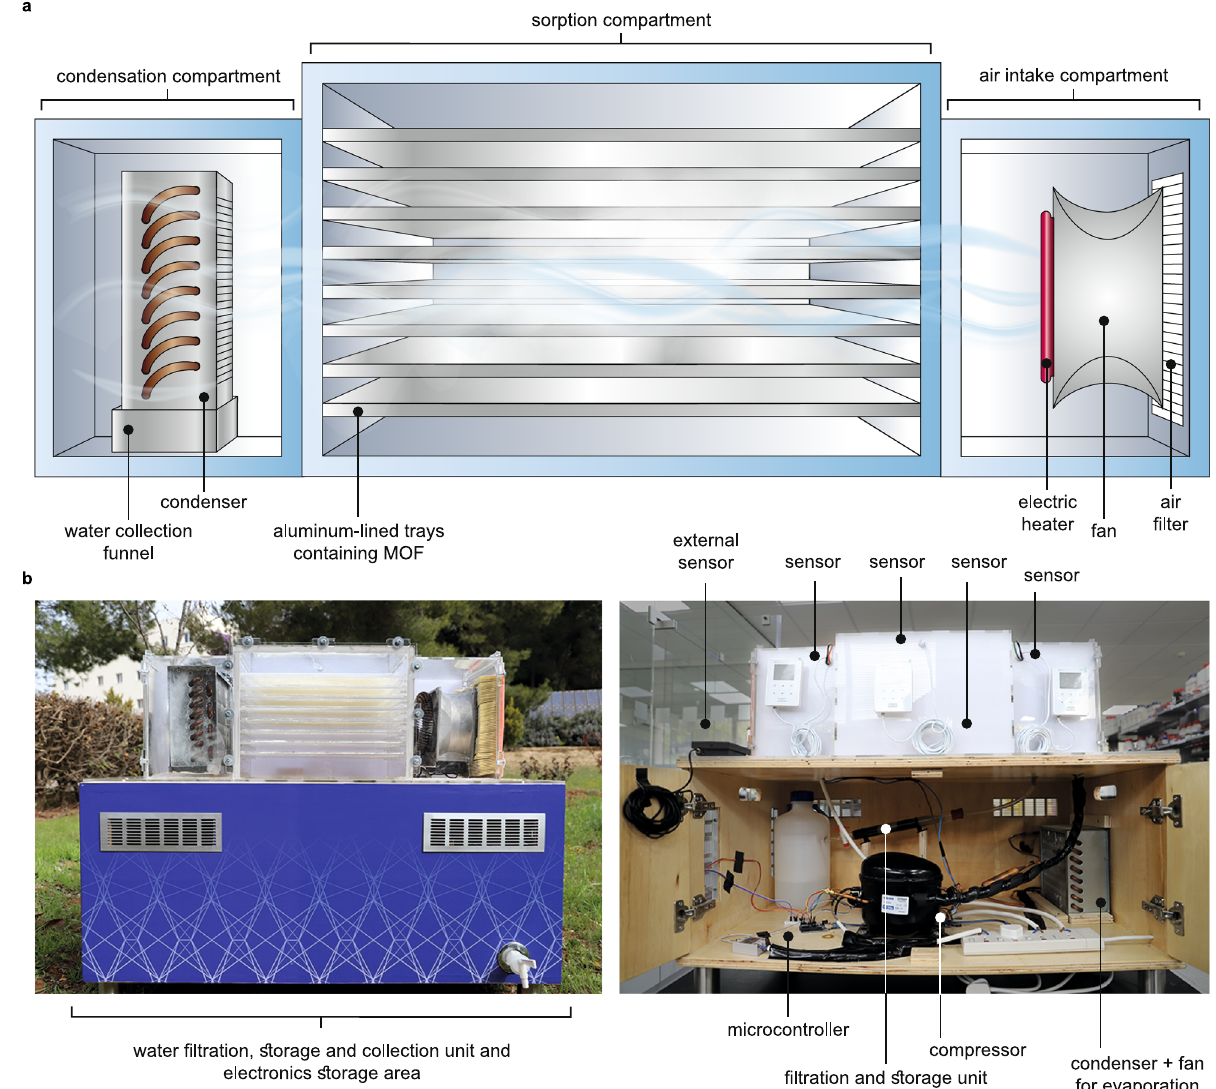
Fig. 1 | MOF water harvester device operating inadaptive mode. a Schematic of the water harvester device detailed herein, which is comprised of three modular compartments: air intake compartment that houses an air fi lter, fan, and electric heater; sorption compartment that holds the MOF-801 adsorbent on aluminum-